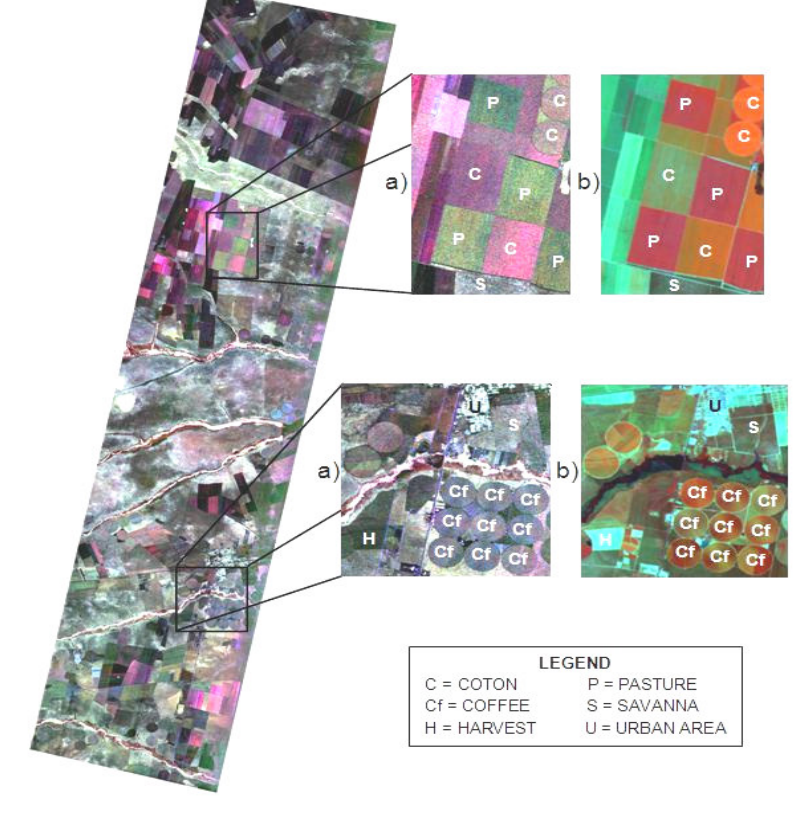
Figure 12. (a) A descending mode simulated MAPSAR geocoded image in color composition (VV-Red, HV-Green, HH-Blue) and (b) equivalent Landsat-5/Thematic Mapper (TM) image in color composition (band 4-Red, band 5-Green, band 3-blue) acquired on April 11,